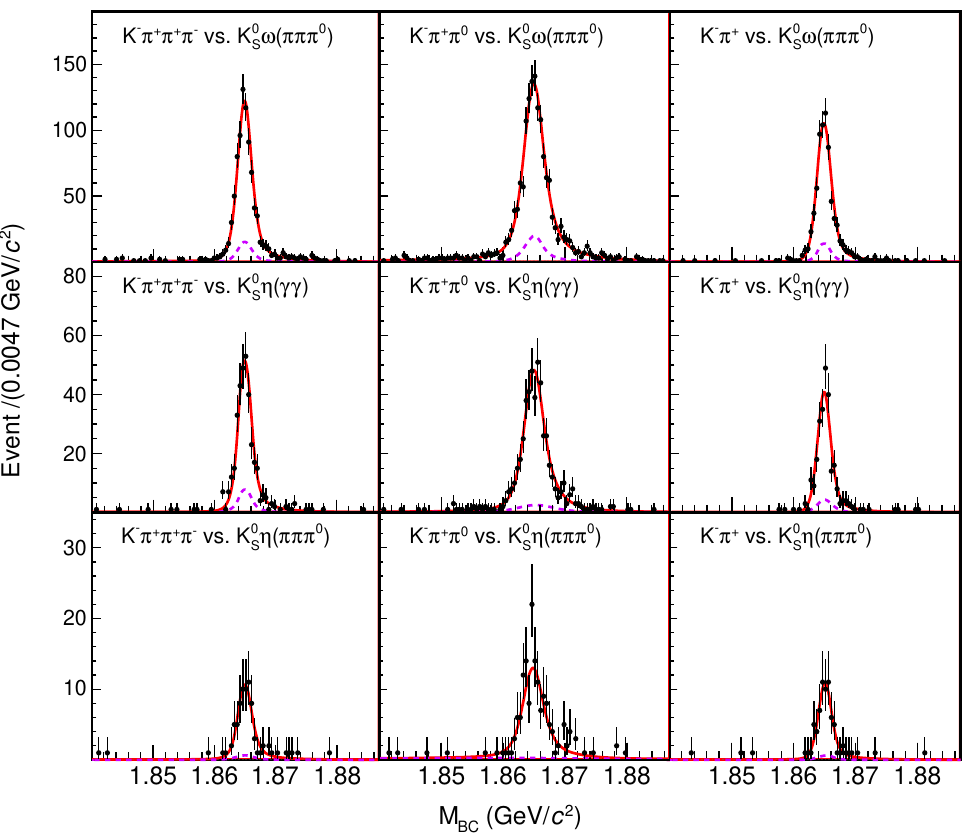
Figure 13 . M BC distributions for decays tagged by the modes D → K 0 and D → K 0 η ( π + π − π 0 ) . The points with error bars are data; the red line indicates the total fit; S the dashed purple line shows the peaking-background contributions; the combinatorial-background contribution is at too low a level to be